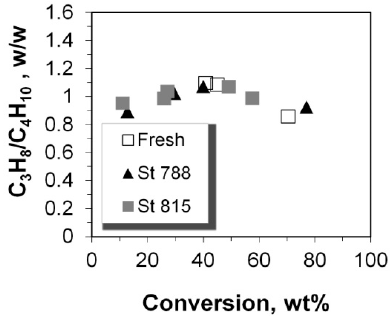
Figure 12. Mass ratio of propane over total butanes versus the conversion of n-C 12 .